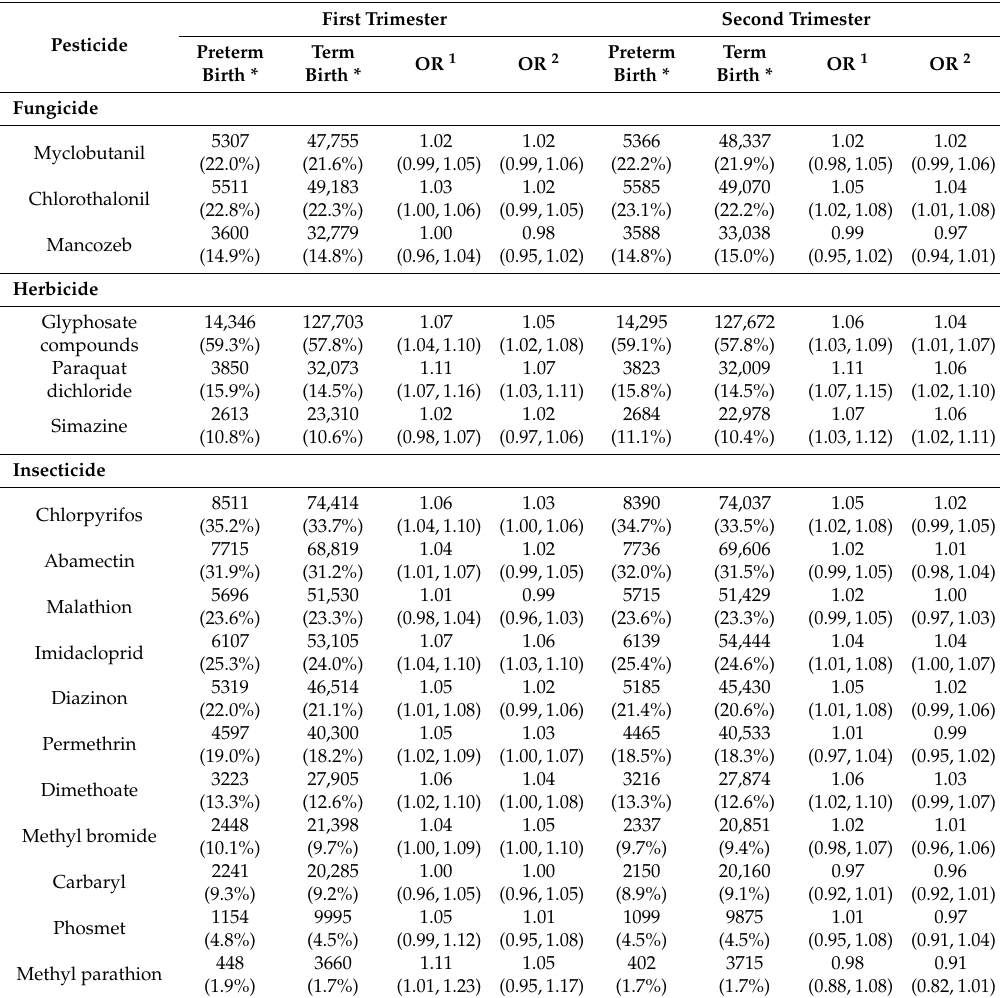
Table 2. Odds ratios (95% confidence intervals) for trimester exposures to individual pesticides (ever vs. never) and preterm